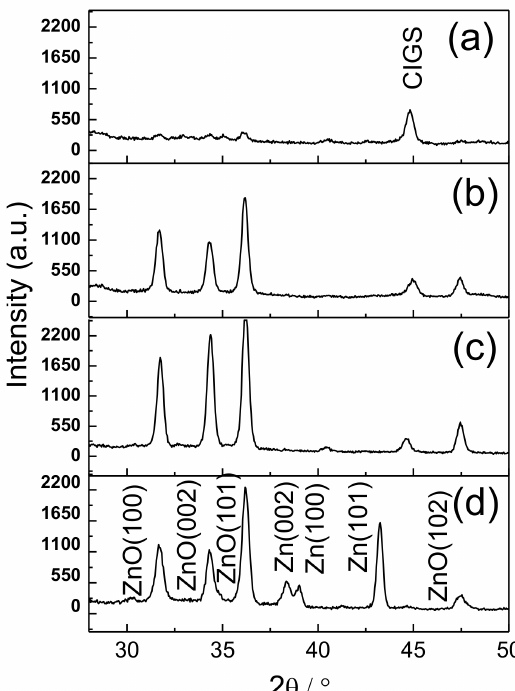
Figure 2. X-ray diffraction (XRD) patterns of Cl-doped ZnO films that were electrodeposited with current densities of ( a ) 0.05, ( b )0.1, ( c ) 0.2, and ( d ) 0.4 mA/cm 2